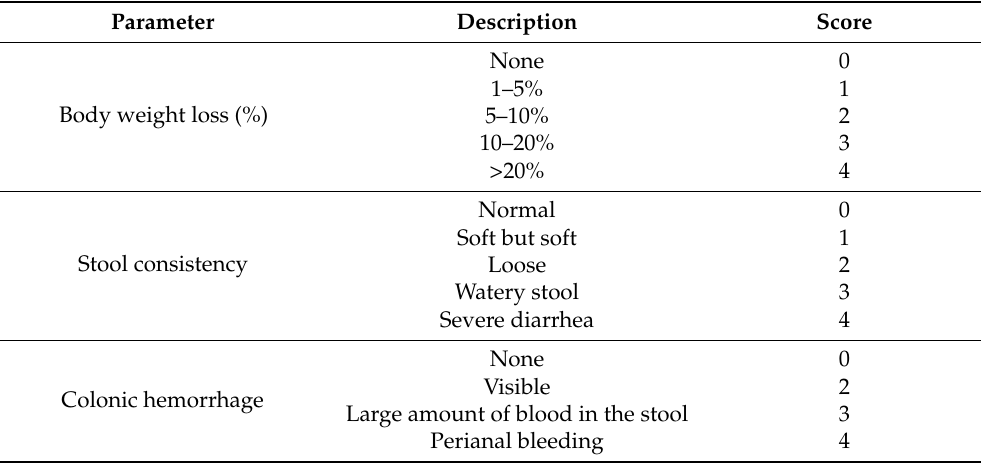
Table 1. Disease Activity Index.